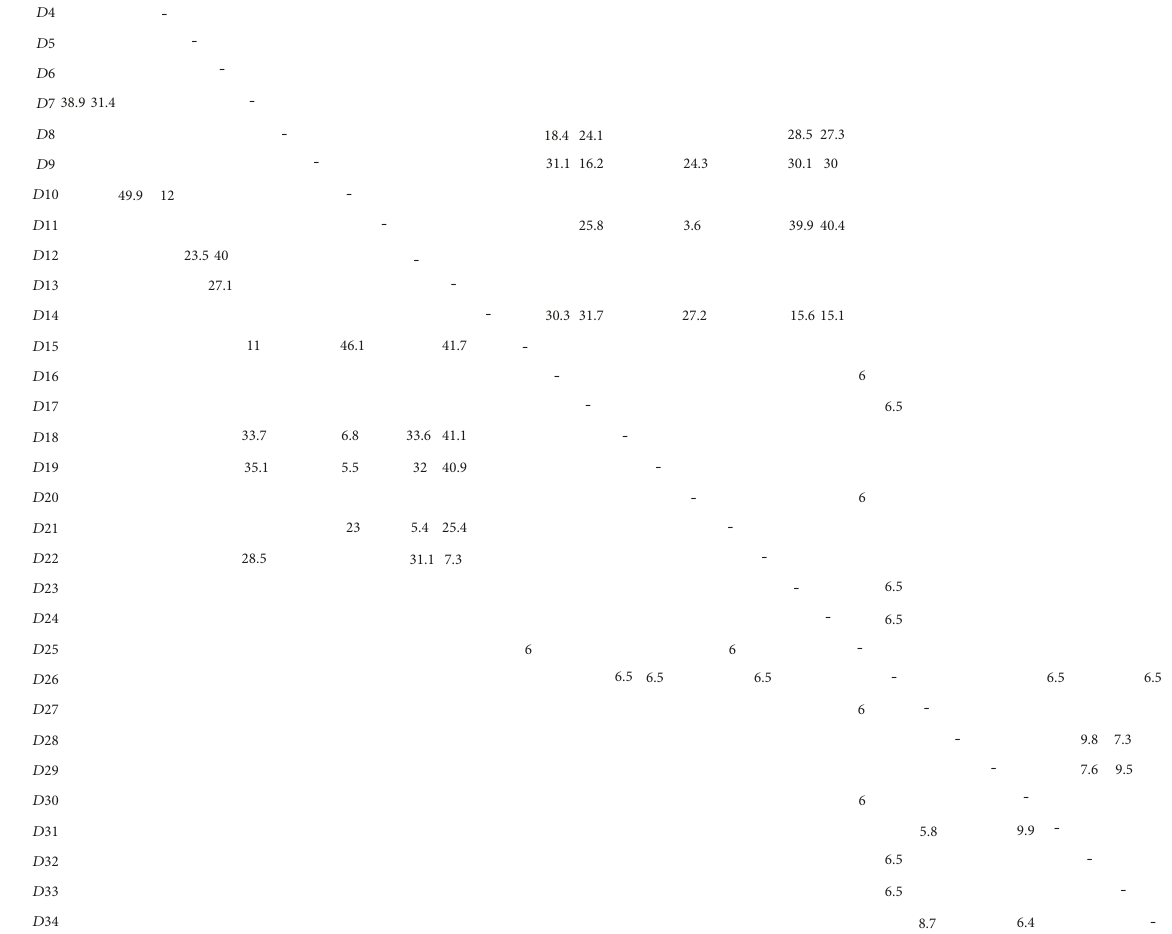
Figure 6: The distance matrix of association network of